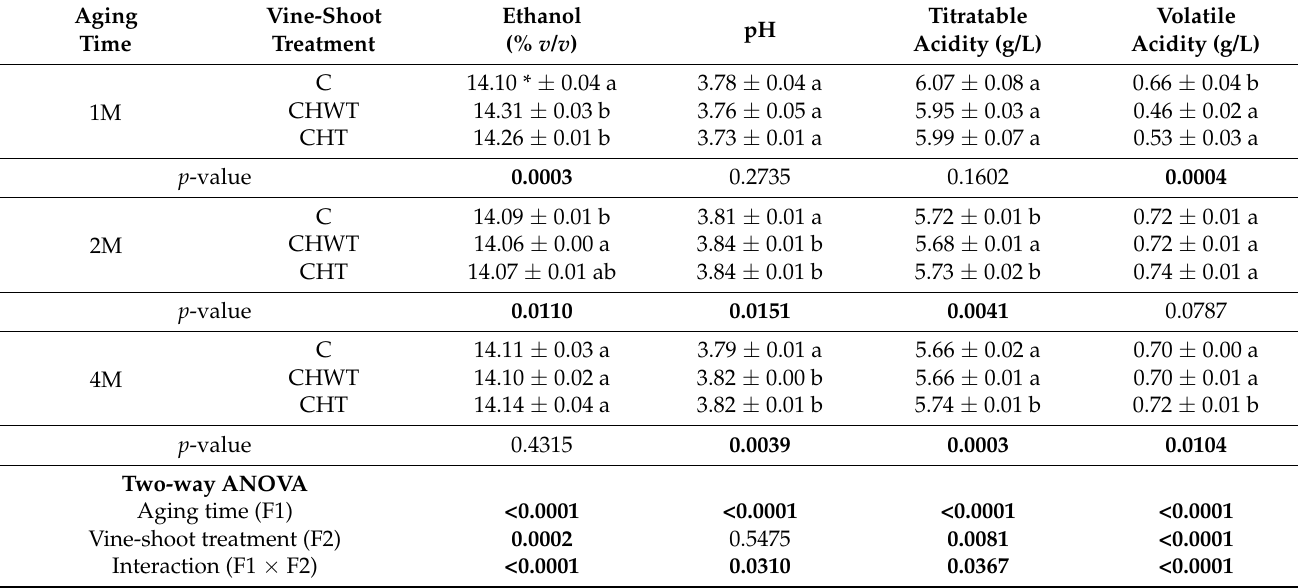
Table 2. Basic chemical parameters of Malbec wines obtained applying vine-shoot chips during aging (Experiment B). Aging